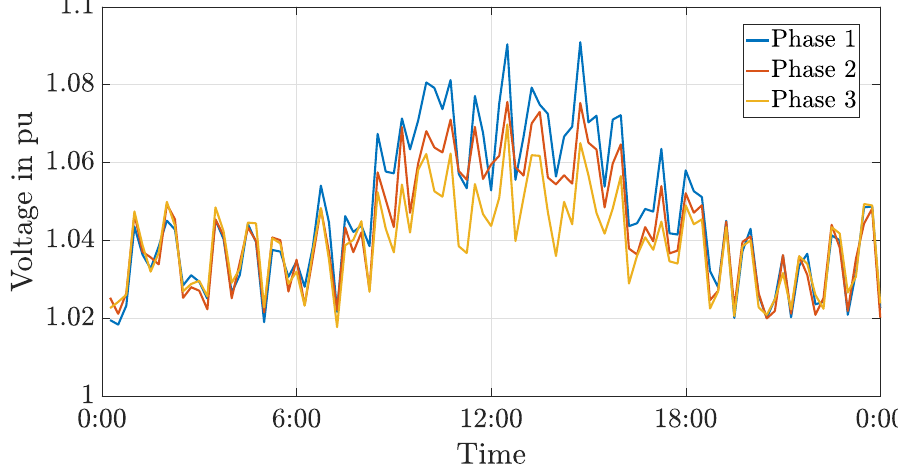
Figure 18. Voltages at the end of the feeder.